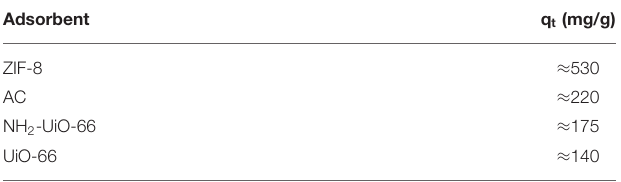
TABLE 1 | Phthalic acid adsorption tests.